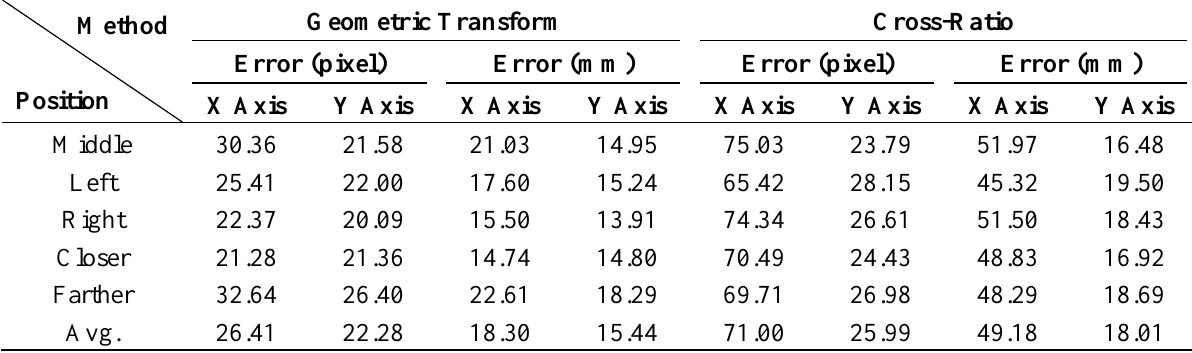
Table 6. Comparisons of gaze tracking error by our geometric transform-based method to that by cross-ratio based one in each sitting position—(2) (10 subjects) (unit: pixel or